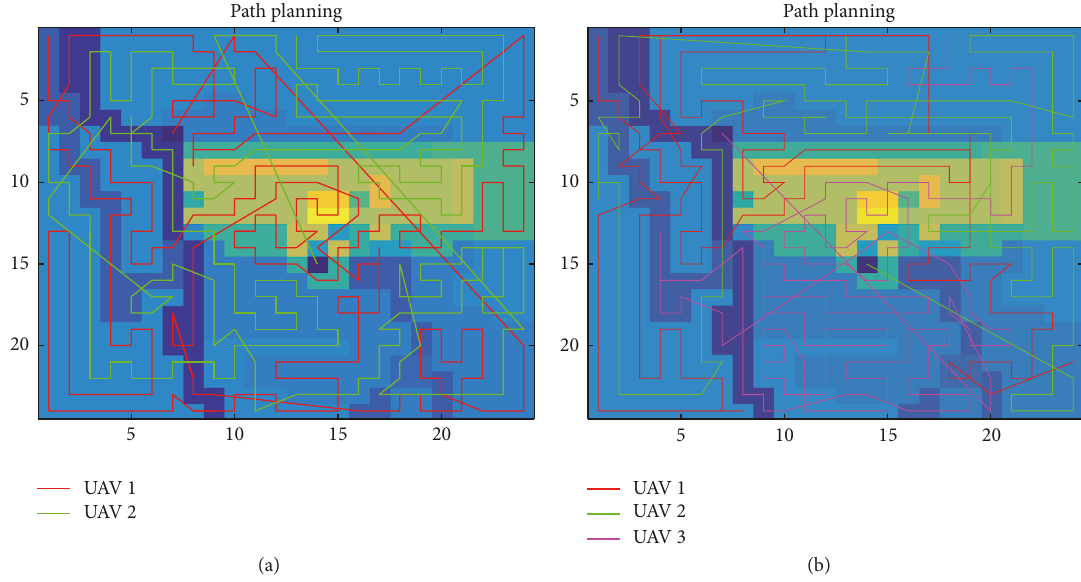
Figure 12: La Palma attraction path planning with 2 UAVs (a) and 3 UAVs (b), free